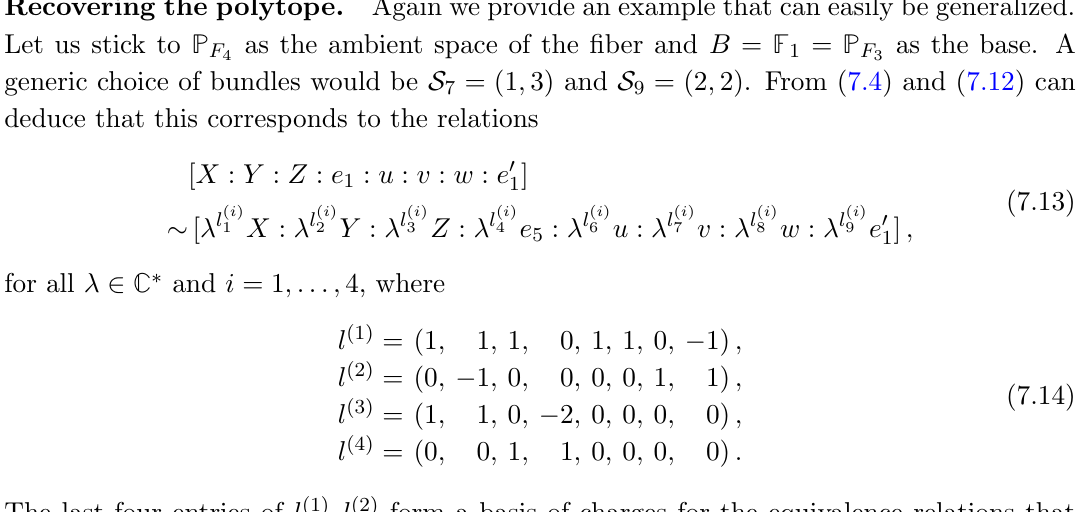
Table 4 . Charges of the homogeneous coordinates on P F divisors on B = F 1 given by u , w for the choice S 7 = (1 ; 3) and S 9 = (2 ; 2). Recovering the